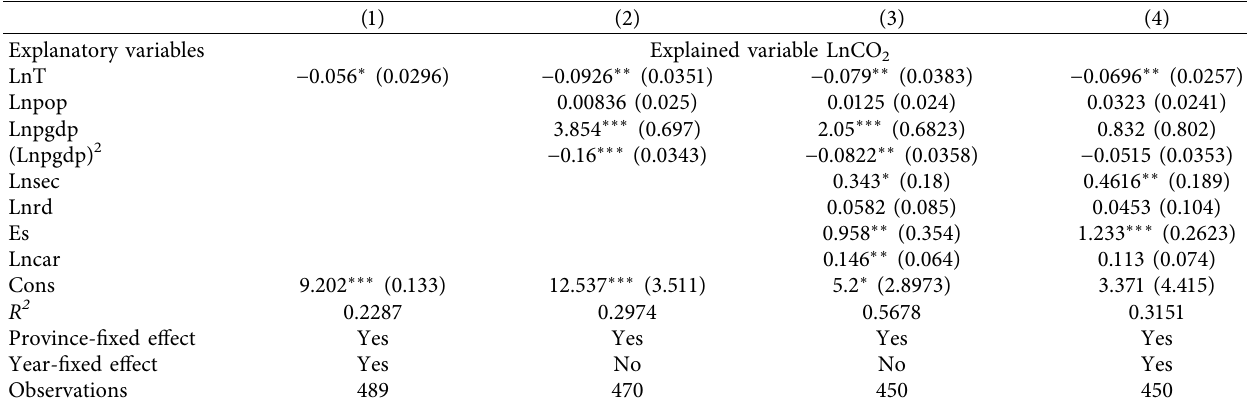
Table 2: Results of benchmark